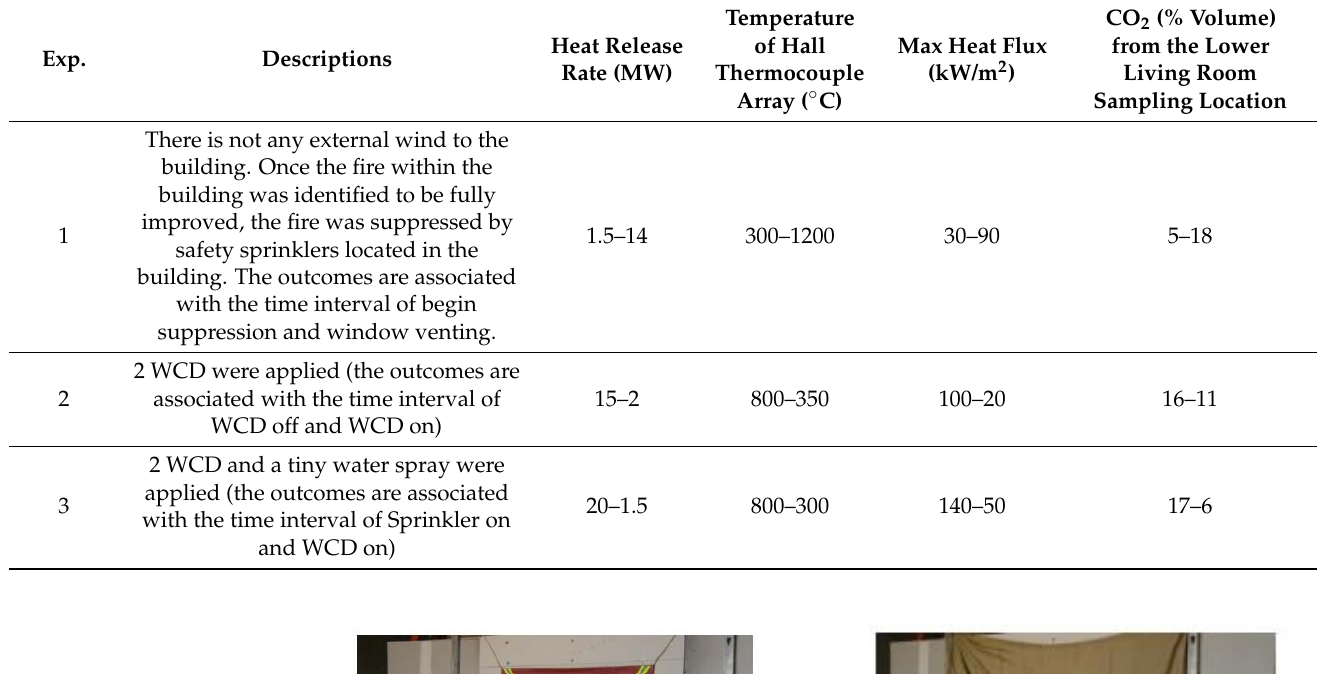
Table 1. The summary of the tests conducted by Kerber and Madrzykowski (2009), [86].